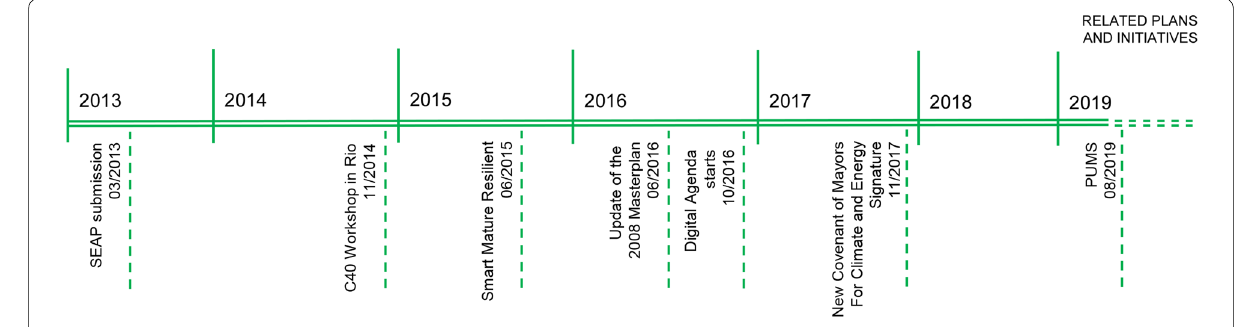
Fig. 9 Plans and initiatives related to Rome Resilience Strategy